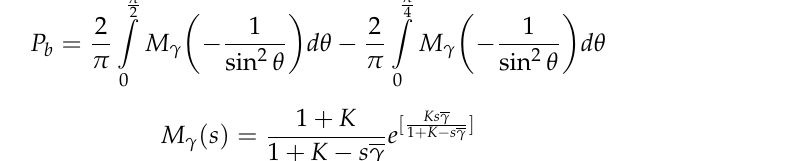
Figure 20. Bit error probability under the AWGN channel as a function of 𝐸 (cid:3046) /𝑁 (cid:2868) . GFSK used in SmartBAN, minimum ‐ shift keying (MSK) and 2FSK are compared.